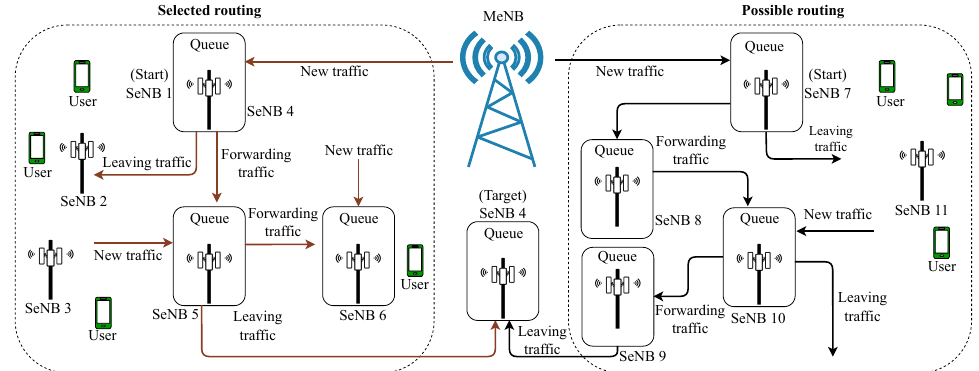
Figure 8. HetSNet routing